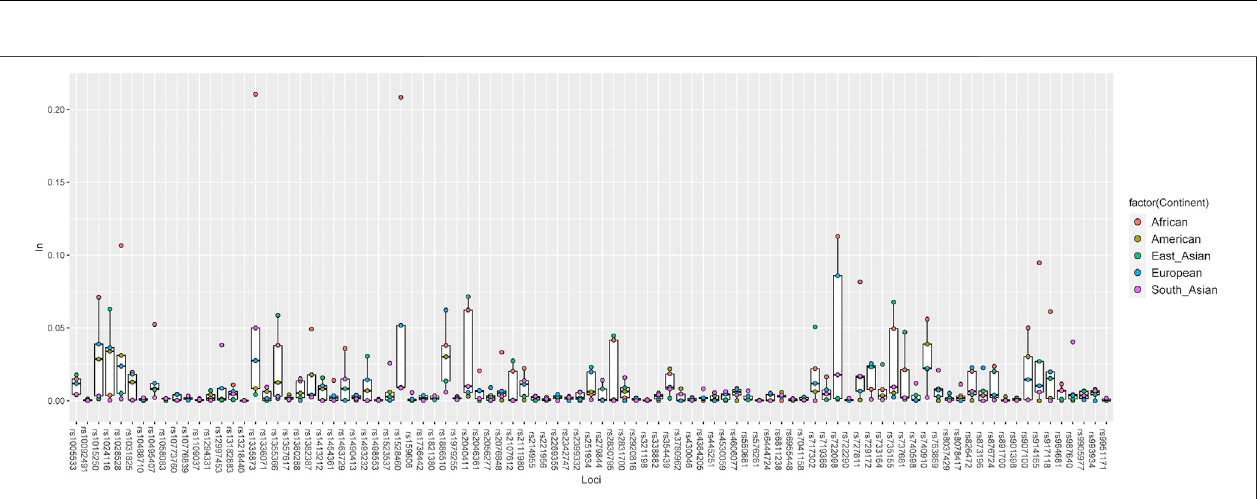
FIGURE 4 | A plot of population-speci fi c divergences for fi ve intercontinental population groups performed based on I n statistic.